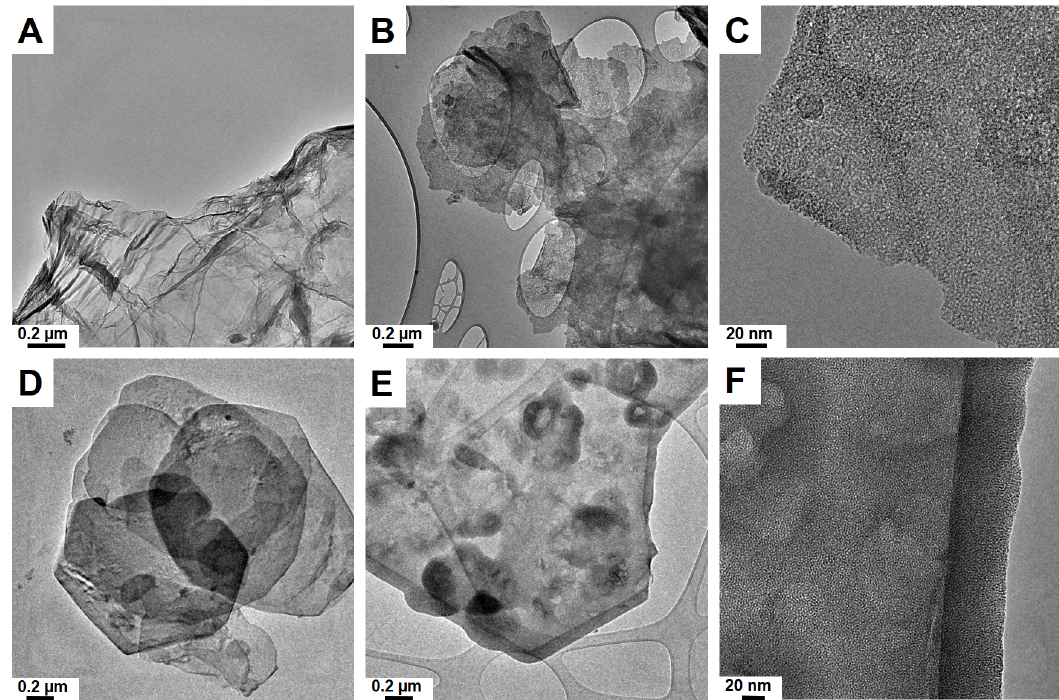
Figure 1. Transmission electron microscopy image of graphene oxide (GO) ( A ) and silica flakes obtained on GO ( B , C ); double-layered magnesium and aluminum hydroxide LDH ( D ) and obtained on LDH Mg/Al ( E , F ).